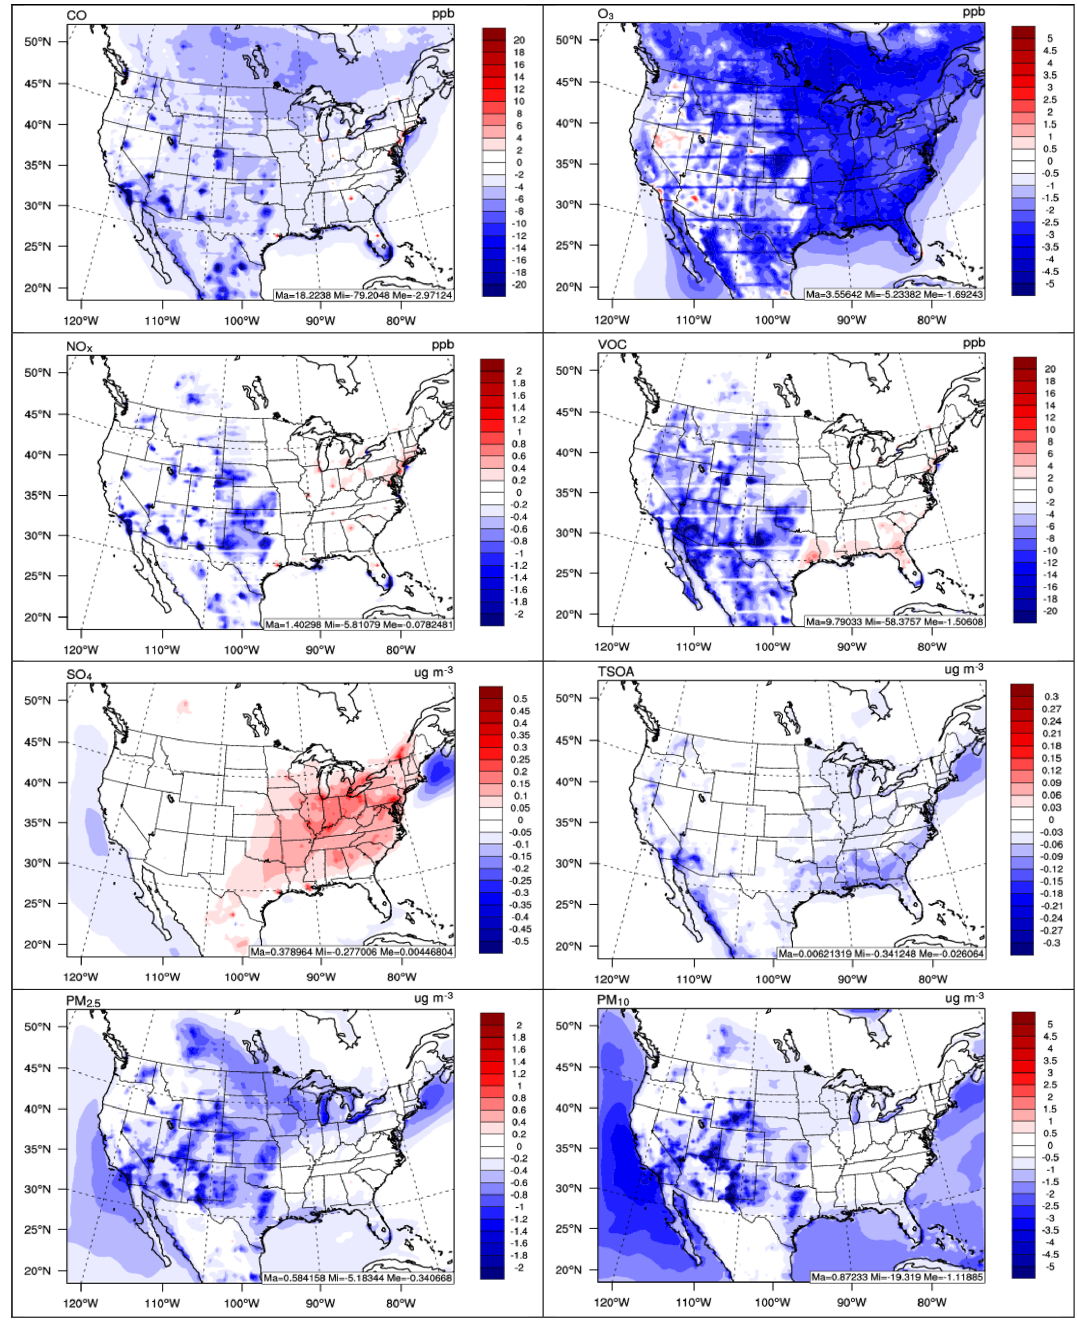
Figure 16. Spatial difference plots (two-way WRF-CMAQ – offline CMAQ) for major chemical species between two-way WRF-CMAQ and offline CMAQ in